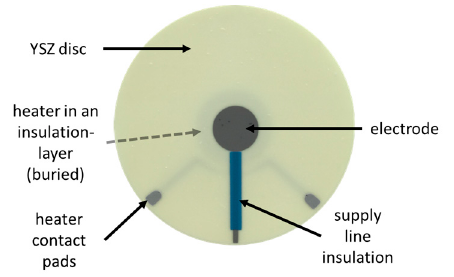
Figure 1. Image of the YSZ sensor disc. The integrated heater meanders around a Pt electrode and is embedded in an insulation layer. It is also buried in the middle of the YSZ disc to provide a homogenous temperature distribution at the electrodes.